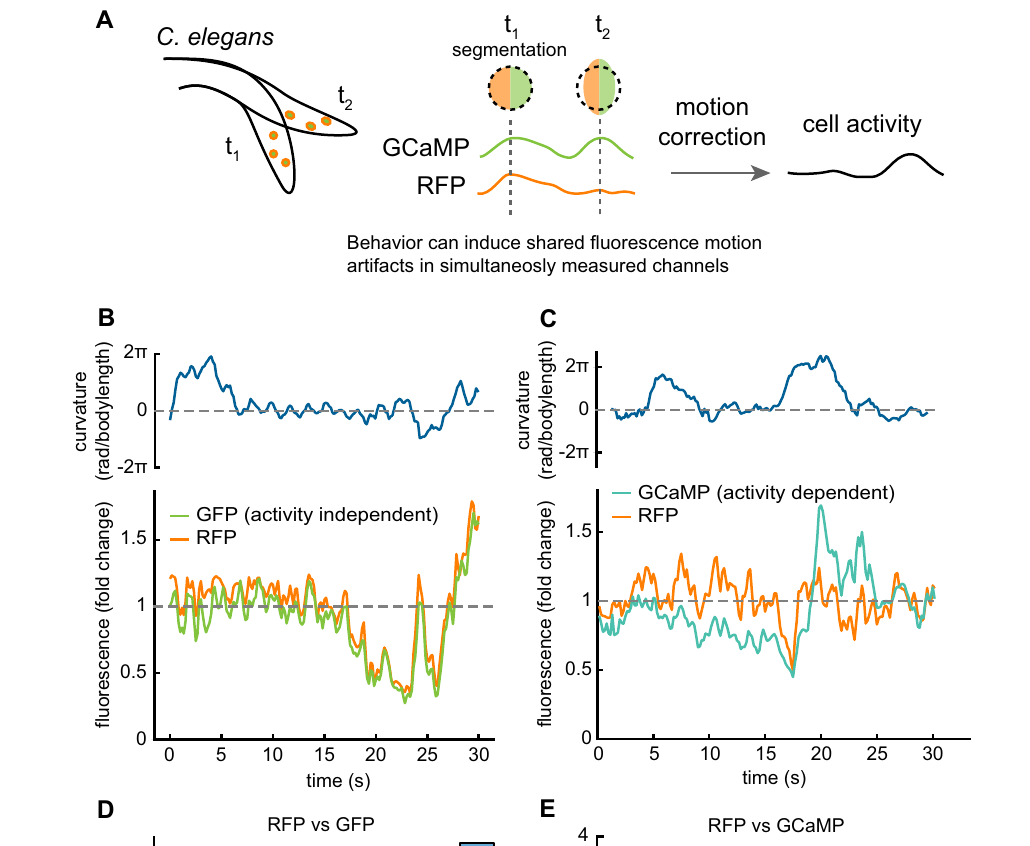
cence intensity during head bending, it may be hard to disambiguate whether that fluorescent